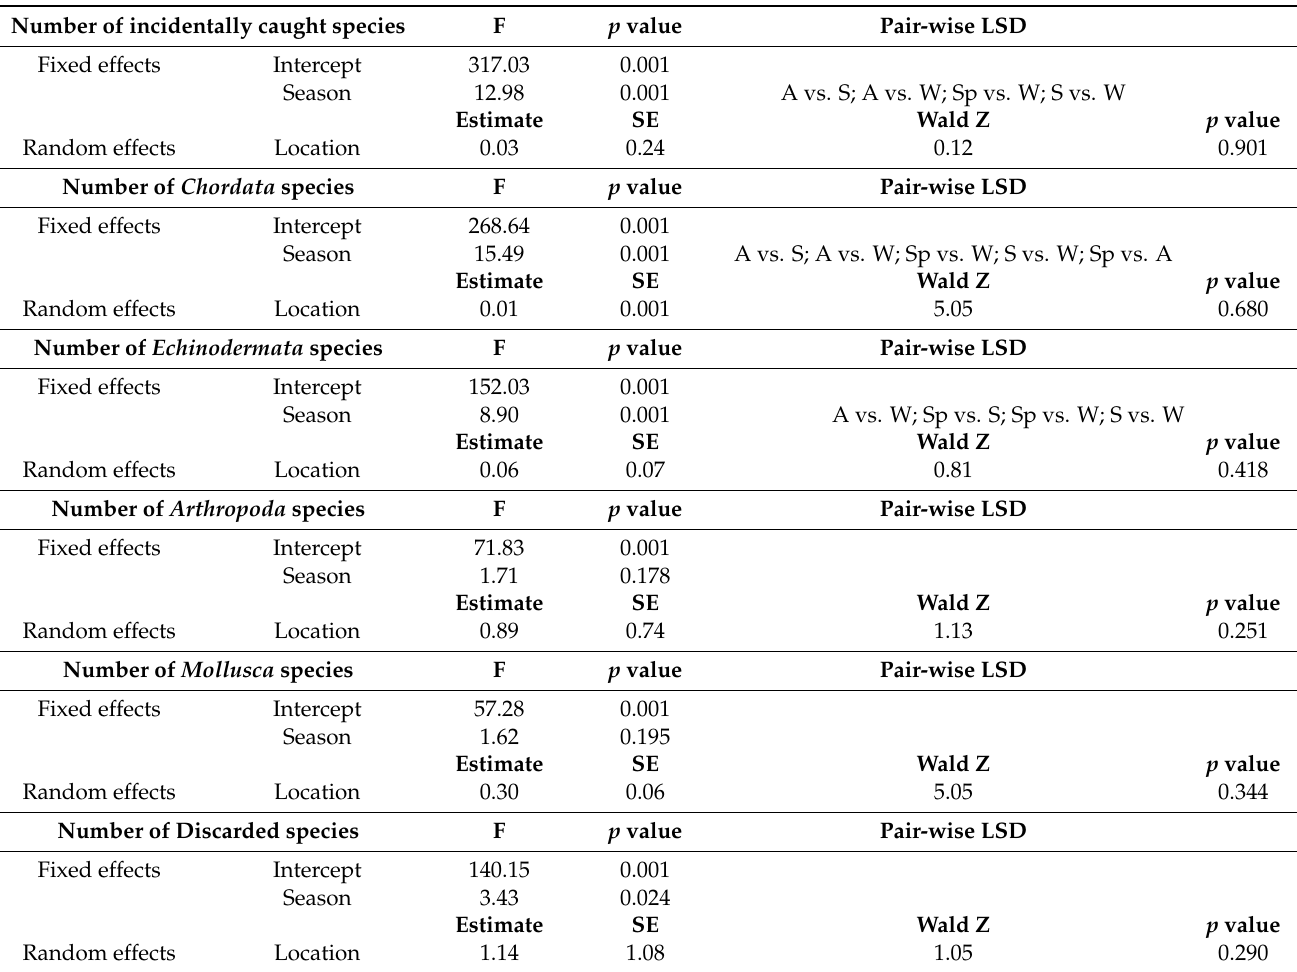
Table A1. Linear Mixed Model effects regarding number of species with season (fixed factor) and location (random factor) as predictors.